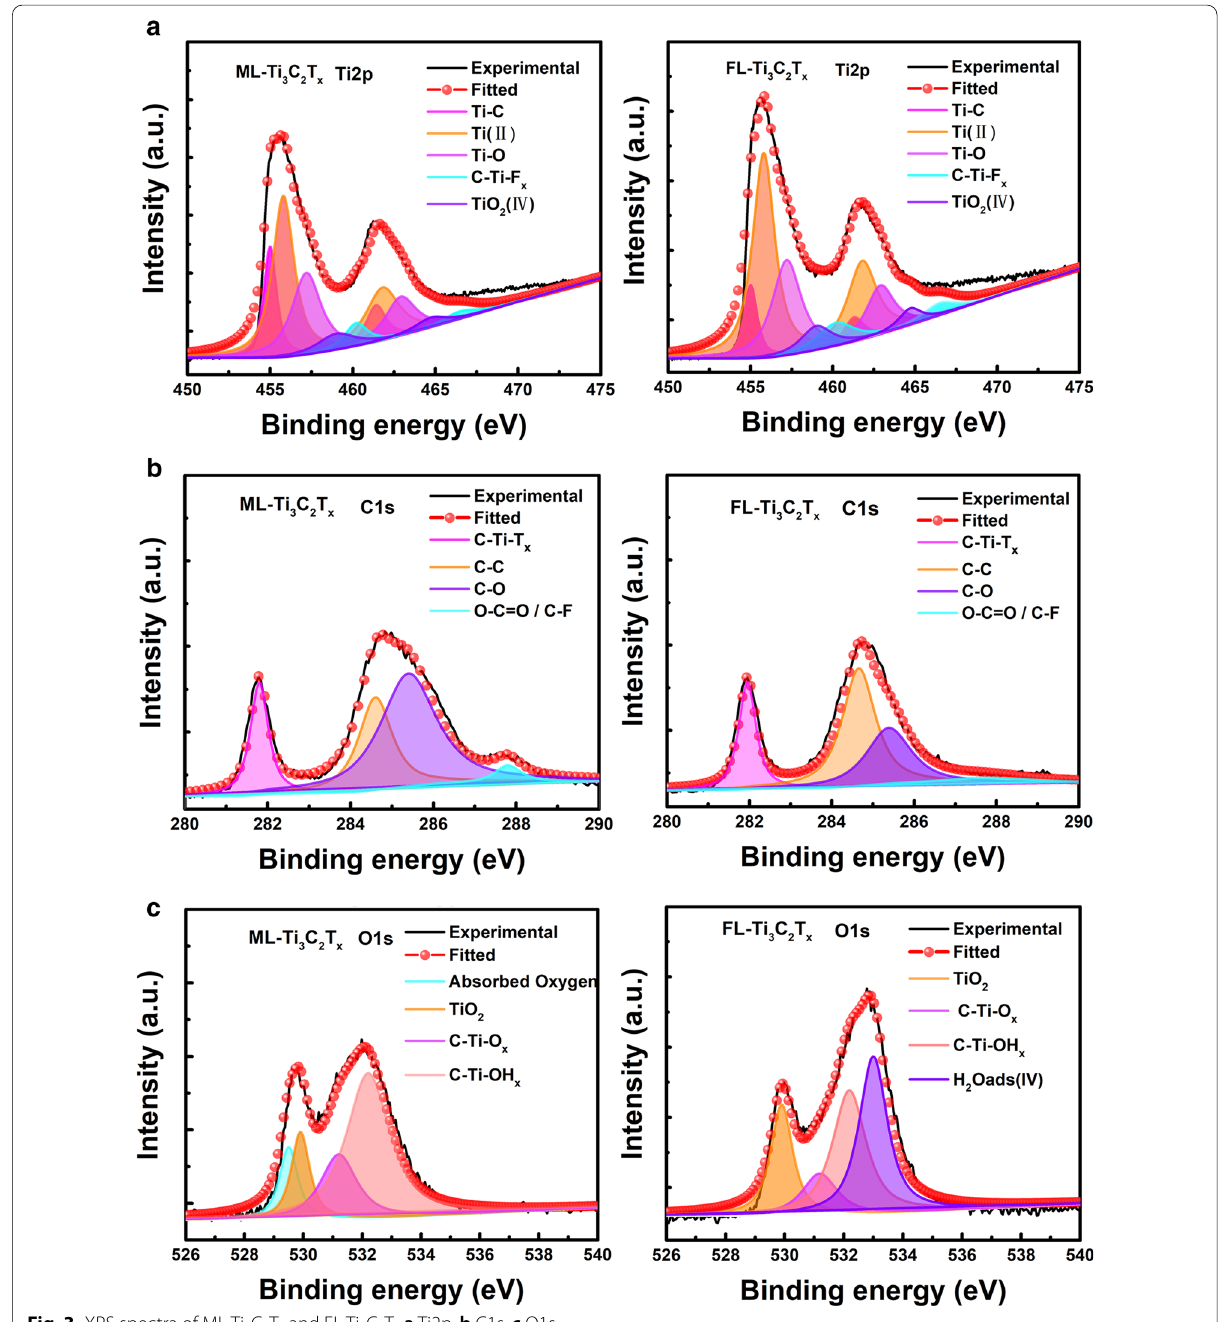
Fig. 3 XPS spectra of ML‑Ti 3 C 2 T x and FL‑Ti 3 C 2 T x a Ti2p, b C1s, c